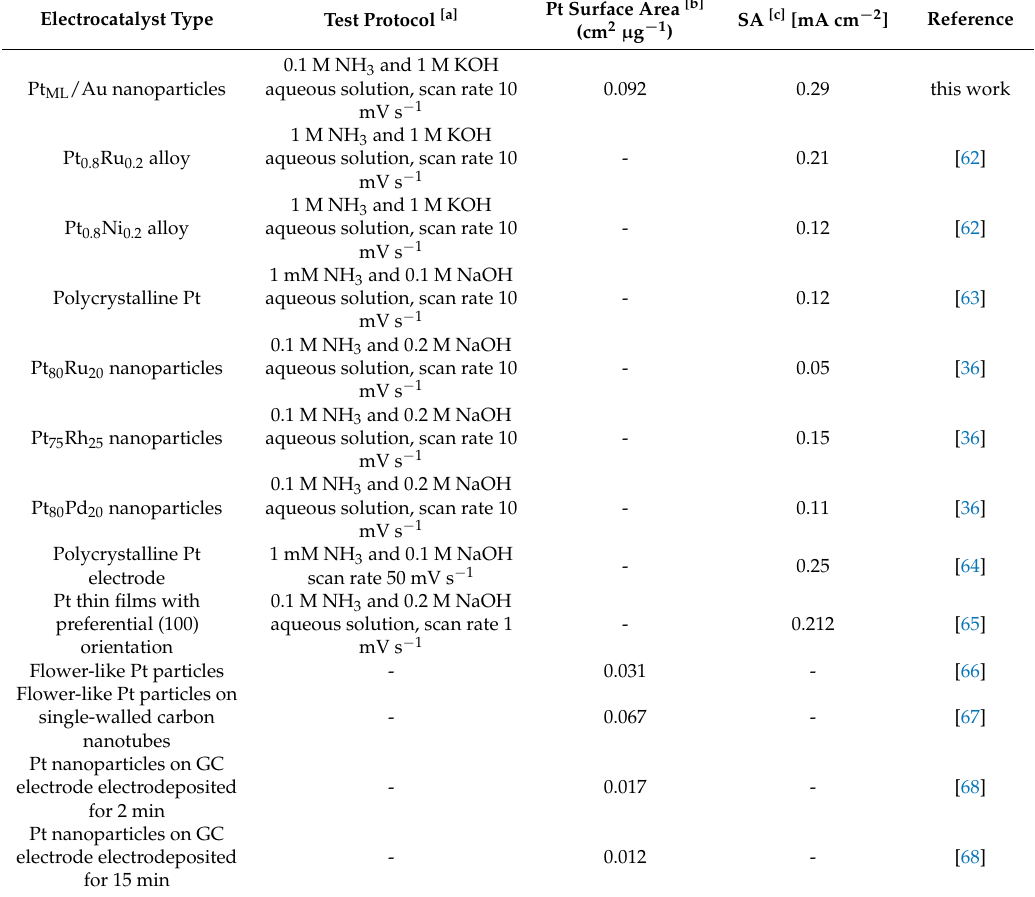
Table 2. Comparison of SA for ammonia electro-oxidation and Pt surface area of as-prepared electrocatalysts with previous